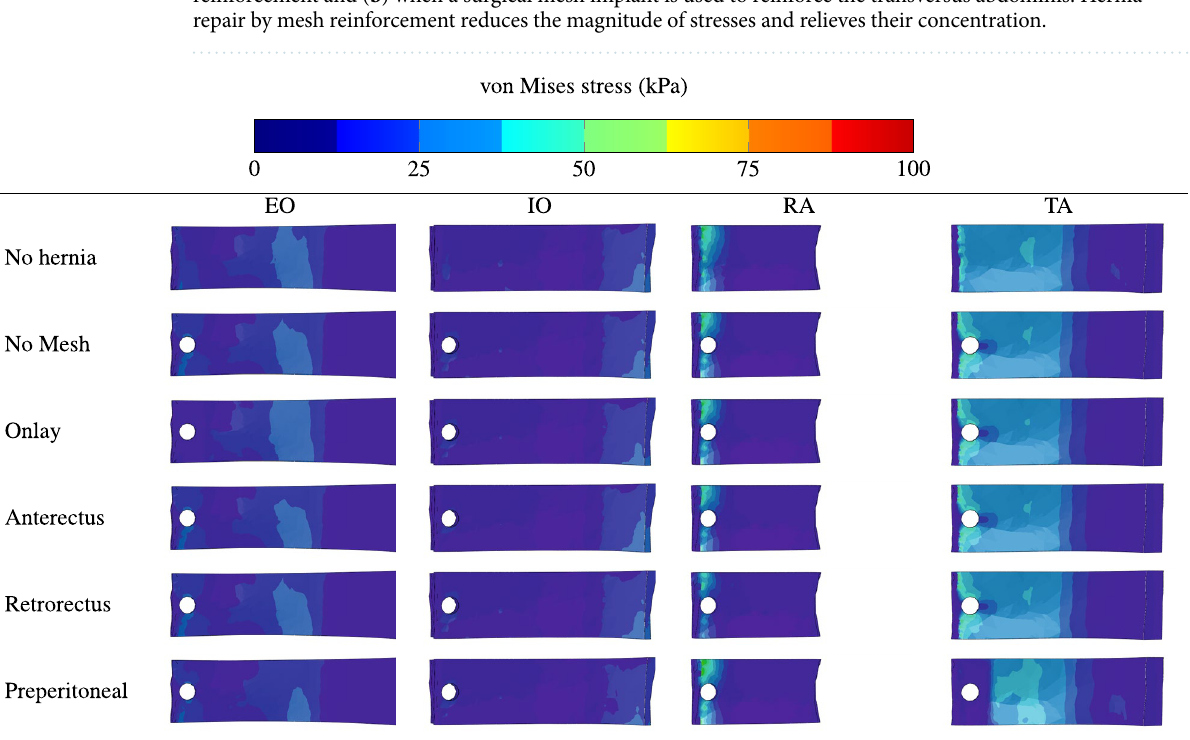
Figure 8. Contours of equivalent stresses in the different AW muscles in the absence of hernia (first row), in the absence of reinforcement and presence of hernia (second row), in the presence of hernia while surgical mesh implants are applied at the onlay (third row), anterectus (fourth row), retrorectus (fifth row), or preperitoneal (sixth row)